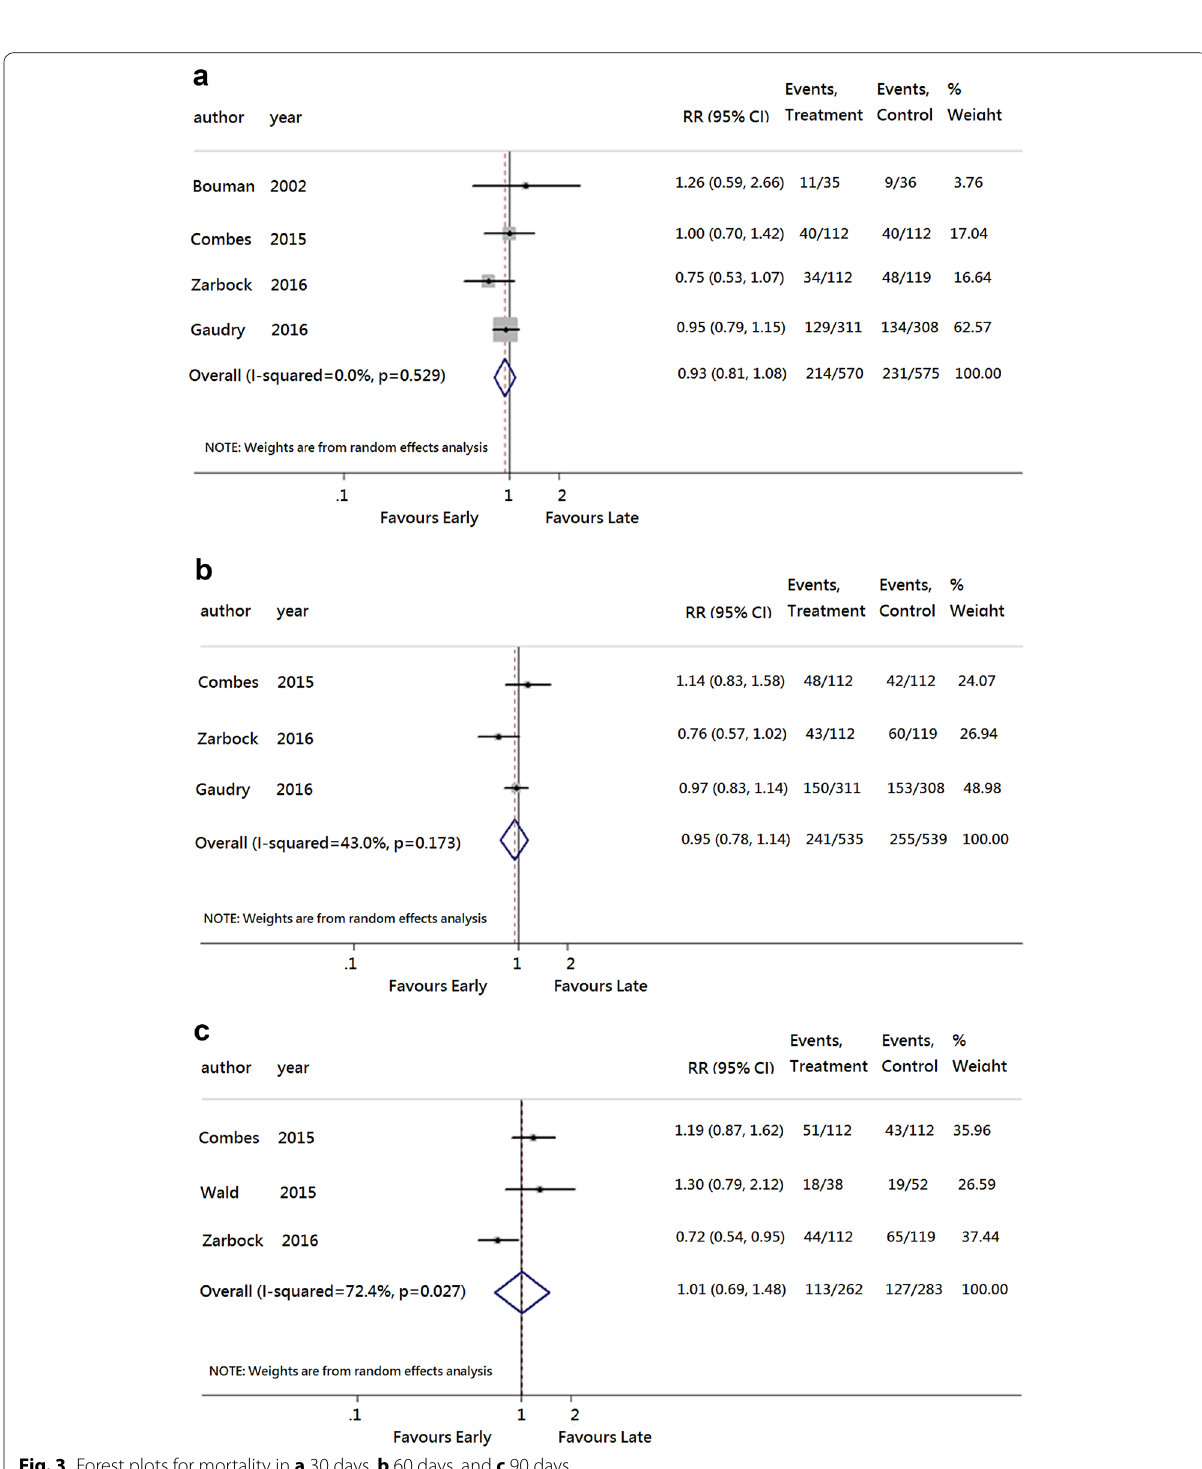
Fig. 3 Forest plots for mortality in a 30 days, b 60 days, and c 90